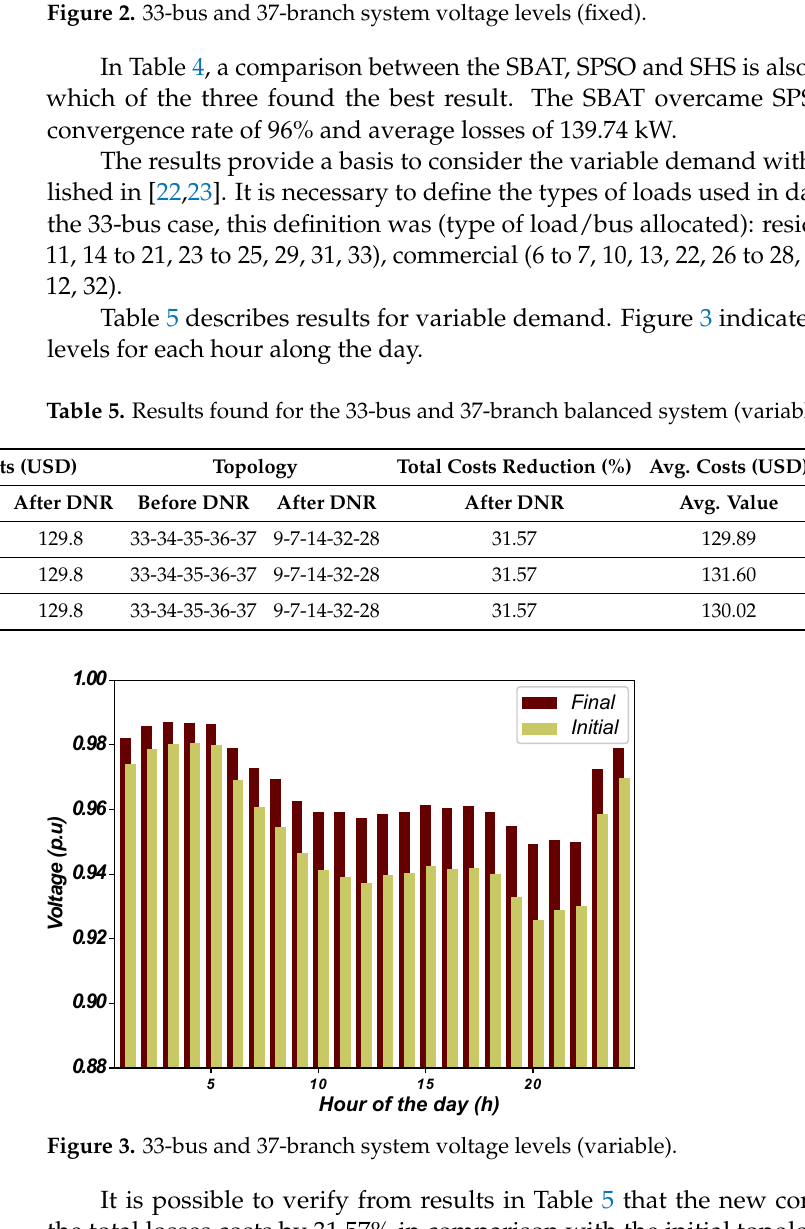
Figure 2. 33-bus and 37-branch system voltage levels (fixed).